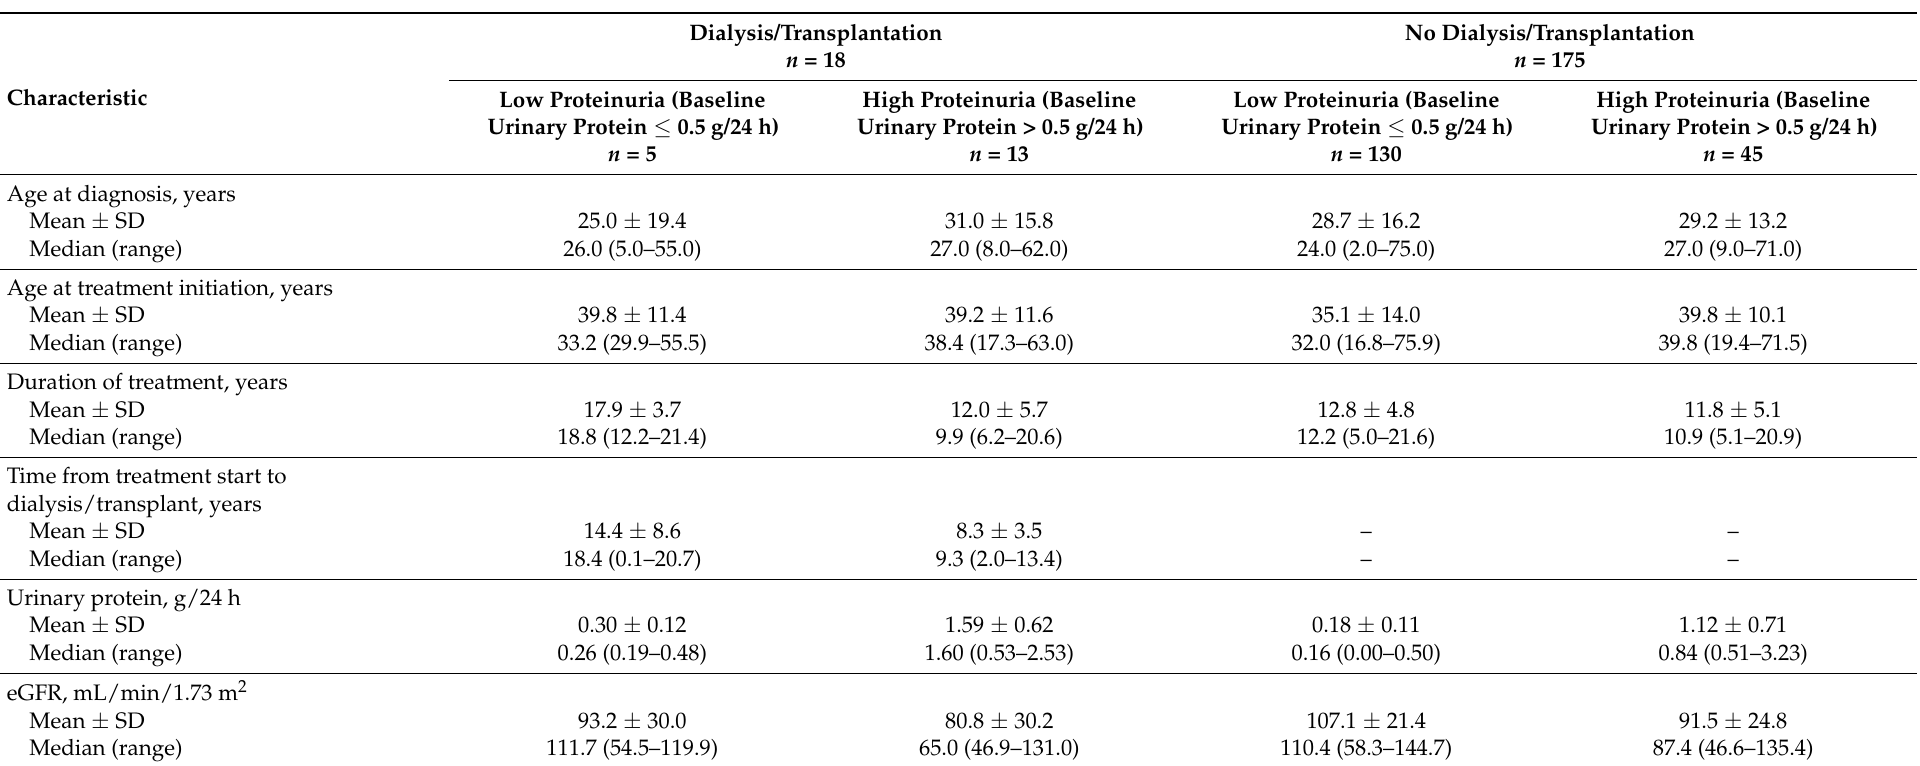
Table 3. Patient characteristics by level of proteinuria at baseline and extent of renal progression to dialysis or transplant after ERT